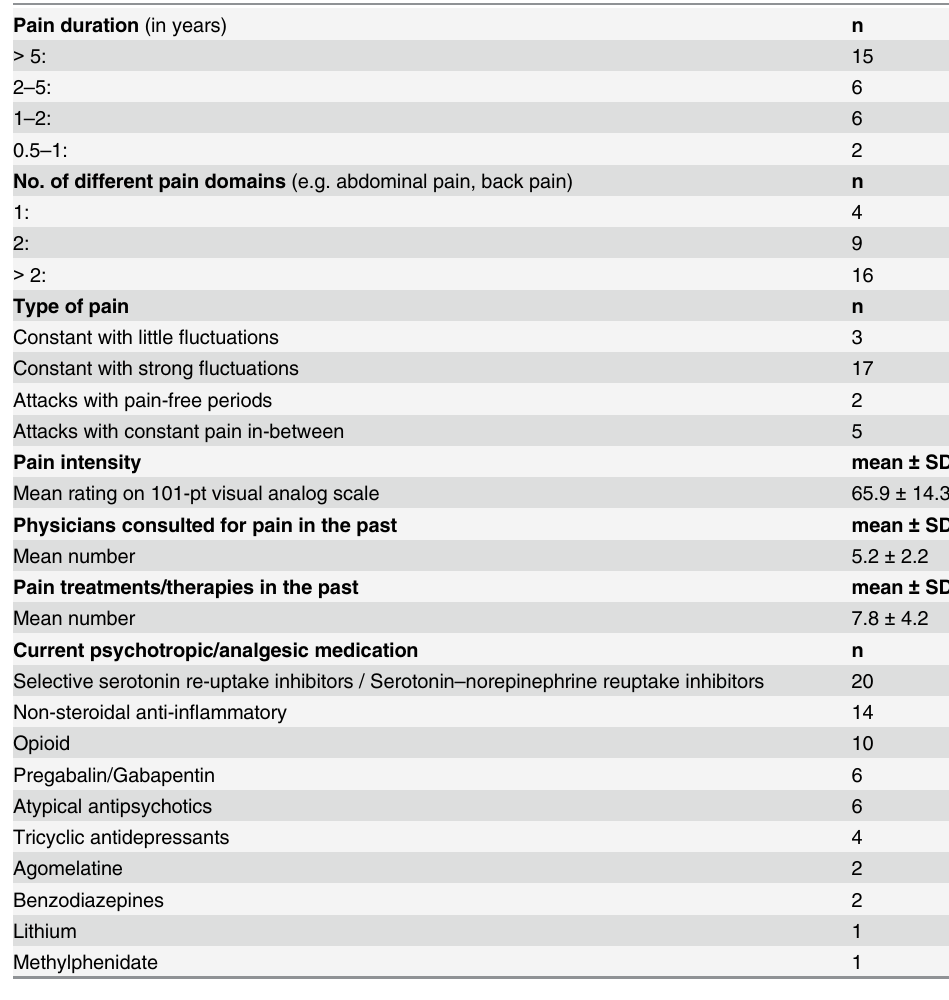
Table 1. Patient